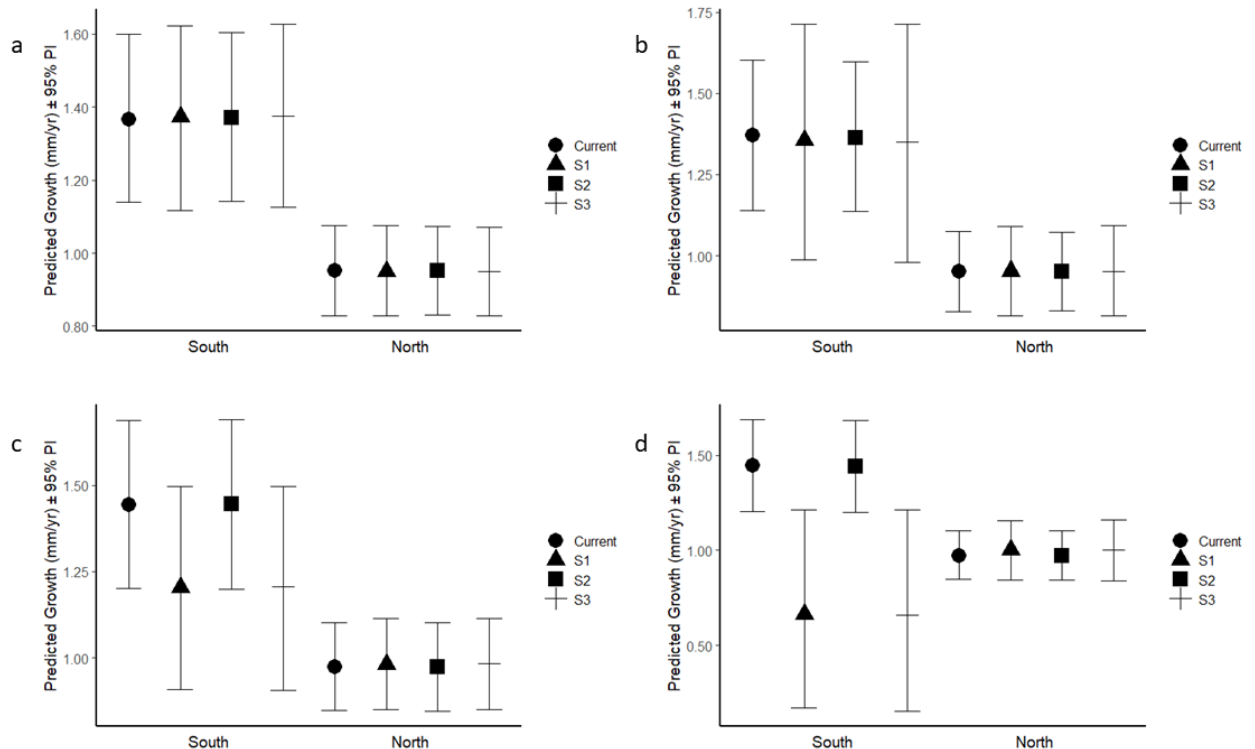
Figure 3. Simulated growth under current conditions, S1, S2 and S3 in north and south for ( a ) Acer rubrum under SSP1 ‐ 2.6 scenario, ( b ) Acer rubrum under SSP5 ‐ 8.5 scenario, ( c ) Acer saccharum under SSP1 ‐ 2.6 scenario, and ( d ) Acer saccharum under SSP5 ‐ 8.5 scenario. Predicted mean + 95%PI.